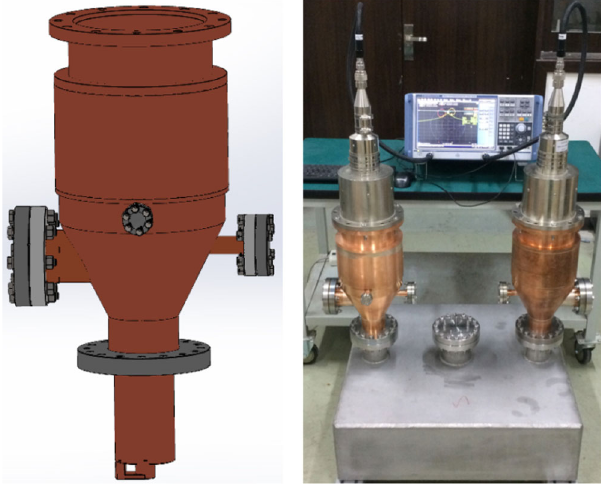
FIG. 8. Structure drawing of the power coupler (left) and two power couplers connecting with one power-conditioning cavity (right).